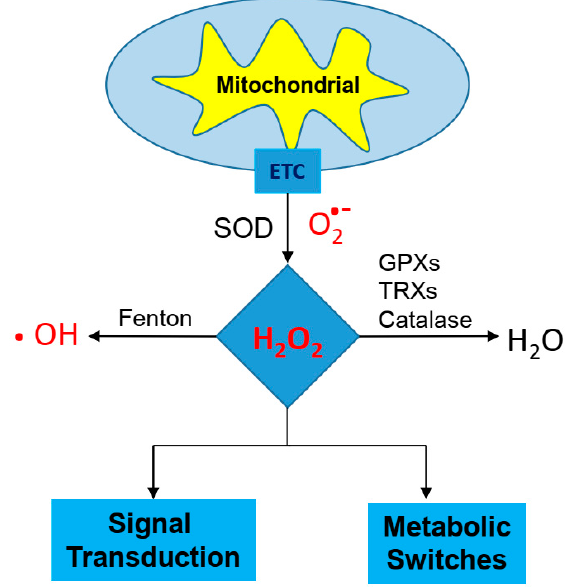
Figure 1. Electron leak generates from the electron transport chain of the mitochondria. Superoxide dismutase (SOD) enzymes convert superoxide molecules into a H 2 O 2 , which can then be reduced to water by glutathione peroxidases (GPXs), thioredoxins (TRXs), or catalase to water (H 2 O) molecules. Hydrogen peroxide can activate the signaling pathway and metabolic adaptations.